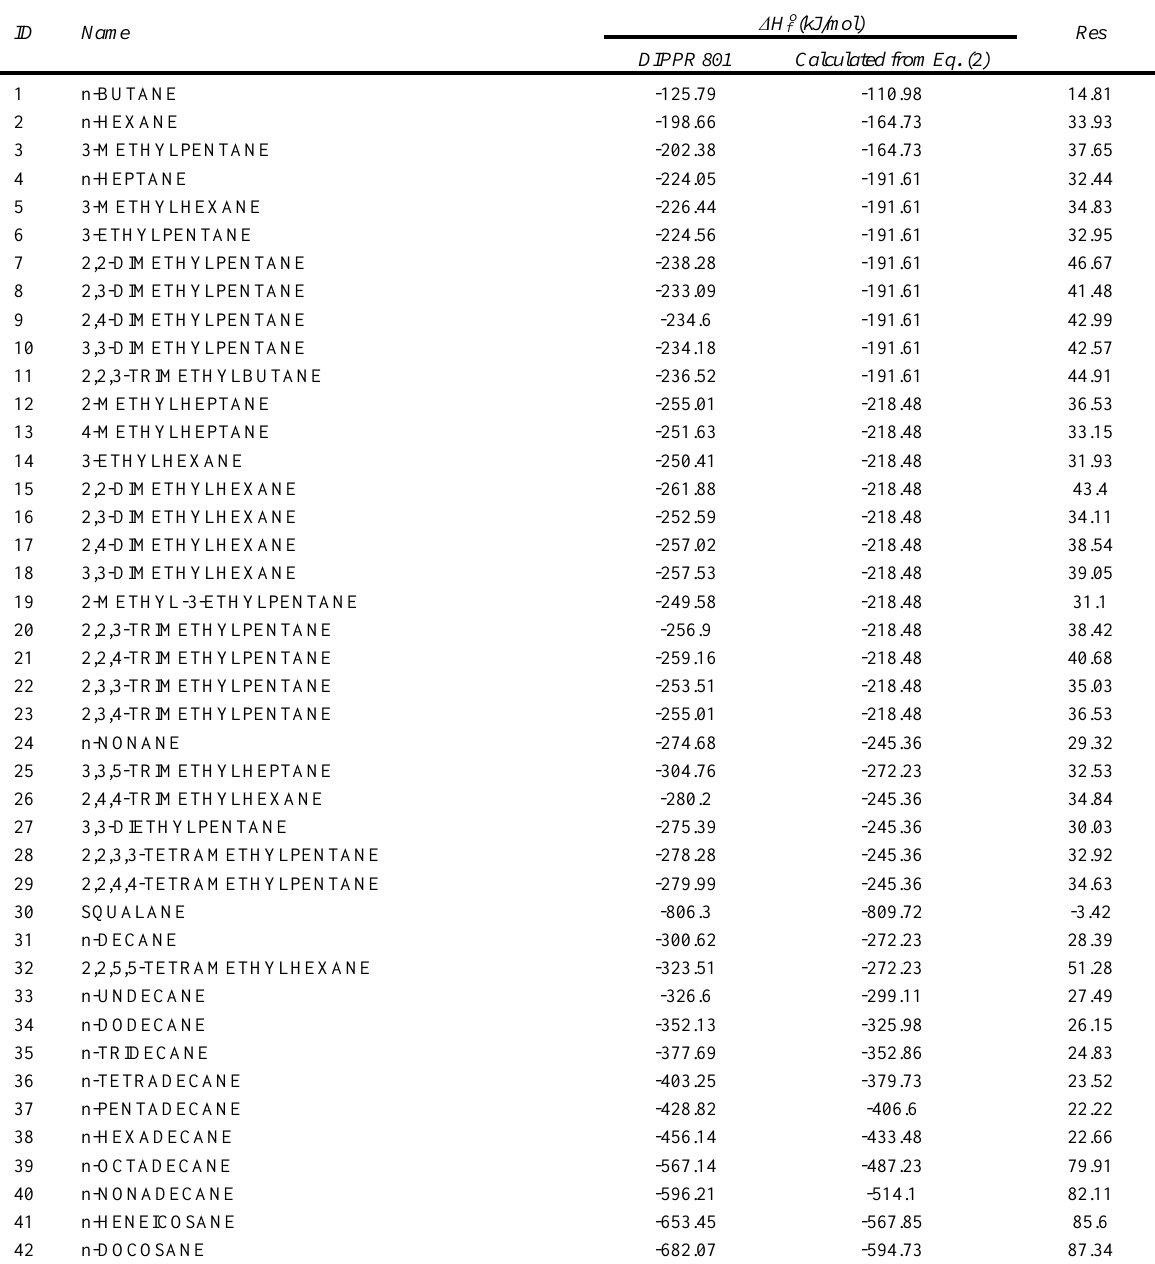
Table 3. The obtained results from Eq. (2) for training